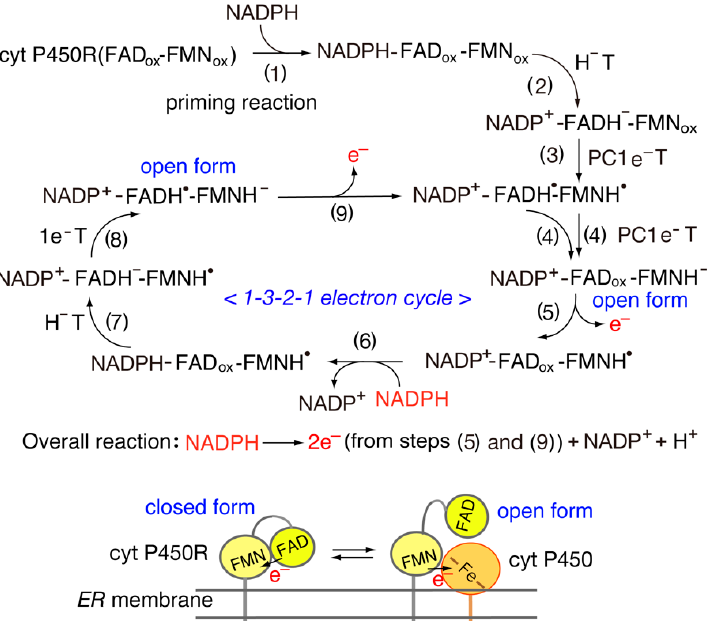
7 of 25 Figure 2. Proposed catalytic cycle of the FNR-Fld systems. ( A ) Photosystem I → Fld (FMN) → FNR (FAD) → NADP + and ( B ) NADPH → FNR (FAD) → Fld (FMN) → metabolic redox pathways. In ( B ), the overall reaction is based on the catalytic cycle. In the first step, NADP + binds to L FNR (FAD ox ). In step 2, reduced Fld (FMNH − ) binds to FNR (FAD ox )-NADP + , and in step 3, the diflavin radical intermediate FMNH • -FADH • - NADP + is formed via a PC1e − T reaction. Such intermediates are observed in the Anabaena PSI/Fld system [51]. In step 4, Fld (FMNH • ) releases, and Fld (FMNH − ) binds. In step 5, FMNH • -FADH − -NADP + is formed during a 1e − T reaction, and in step 6, FMNH • -FAD ox - NADPH is formed during an H − T reaction. In the final step, Fld (FMNH • ) and NADPH are released. The catalytic cycle of the non-photosystem includes the priming reaction (Figure 2B).